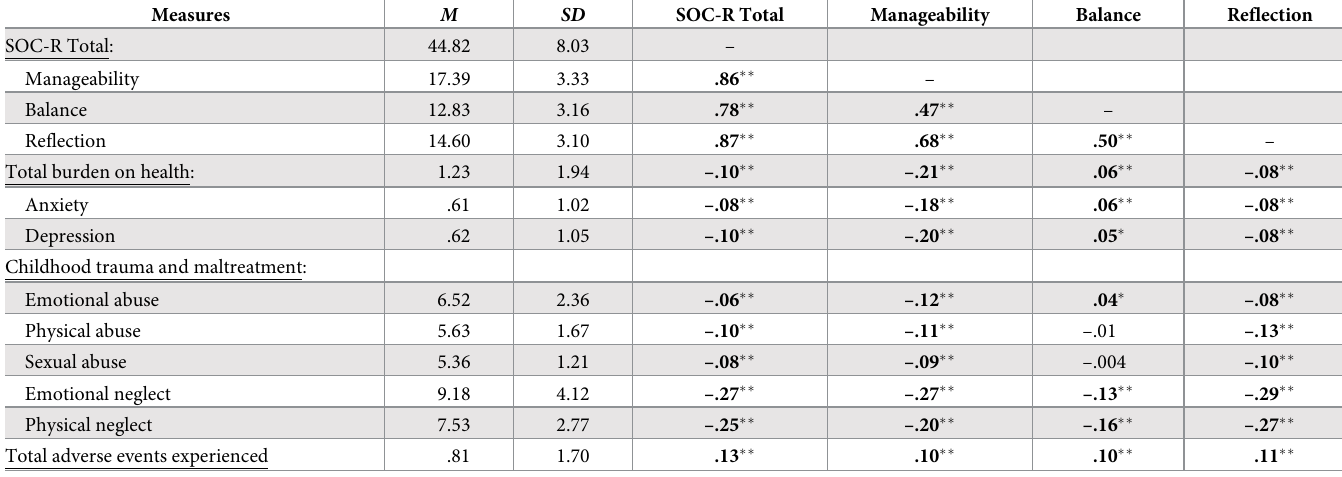
Table 3. Discriminant correlations of revised sense of coherence (SOC-R) scale with psychopathological measures. Measures